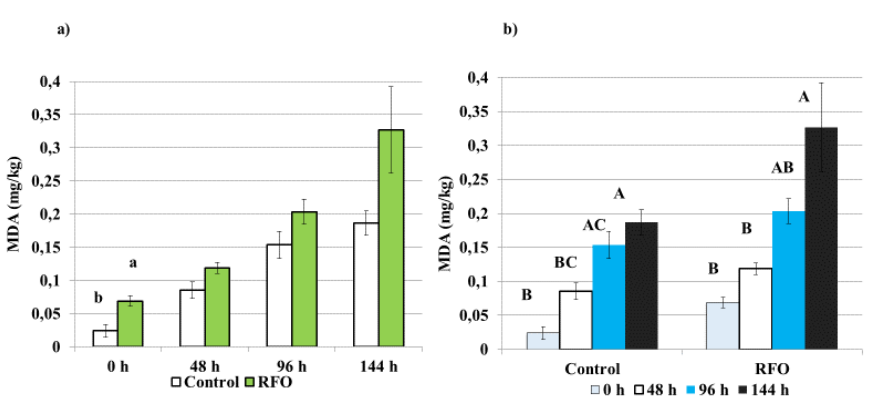
Figure 1. Effect of raffinose family oligosaccharides (RFO) prebiotic treatment on thiobarbituric acid-reactive (TBA) substances values (mg malondialdehyde (MDA) / kg of meat) in breast muscle, Pectoralis superficialis ( a ) and lipid oxidation progression in breast muscle within each treatment ( b ), during the storage at 4 ◦ C. TBA values were compared between RFO prebiotic and the Control treatments on days 0 (0 h), 2 (48 h), 4 (96 h) and 6 (144 h) of meat storage. The assessment involved 2 separate houses, one for prebiotic and one for the Control. The replicate was TBA-reactive substances values per randomly selected bird. There were n = 15 birds selected for RFO and Control group. For each bird, there were 3 samples (repetitions) taken for each storage time point and each sample was analyzed in duplicate. The charts represent means ± standard error (SE) bars. A, B, C: p < 0.001; a,b: p <